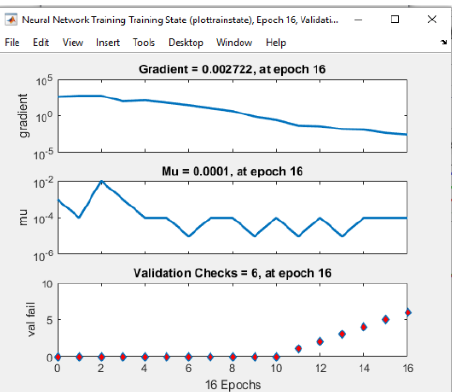
Figure 17 . shows variation in gradient coefficient with respect to number of epochs. The final value of gradient coefficient at epoch number 16 is 0.02 which is approximate near to zero. Minimum the